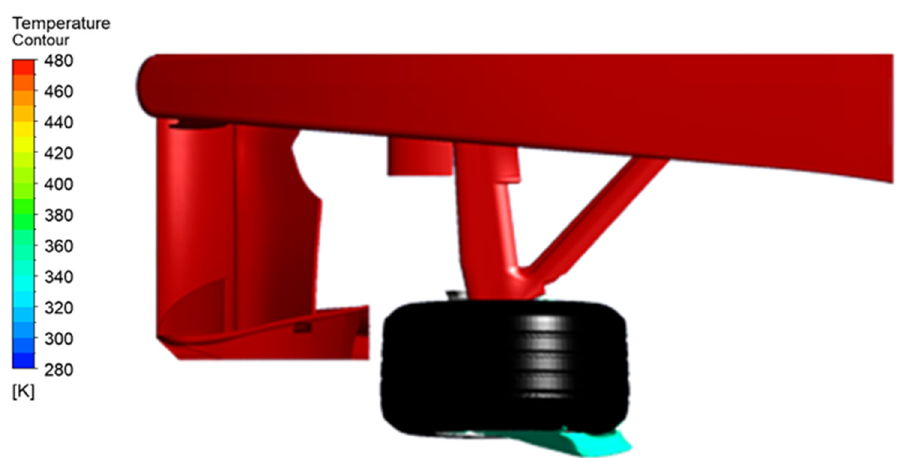
Figure 14. Temperature surface (350 K) of the hot air that leaves the wheel rim.